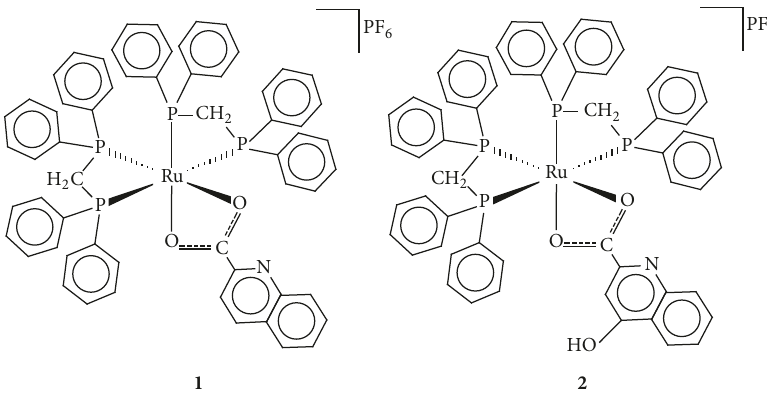
Figure 1: Structures of the ruthenium(II) compounds obtained in this